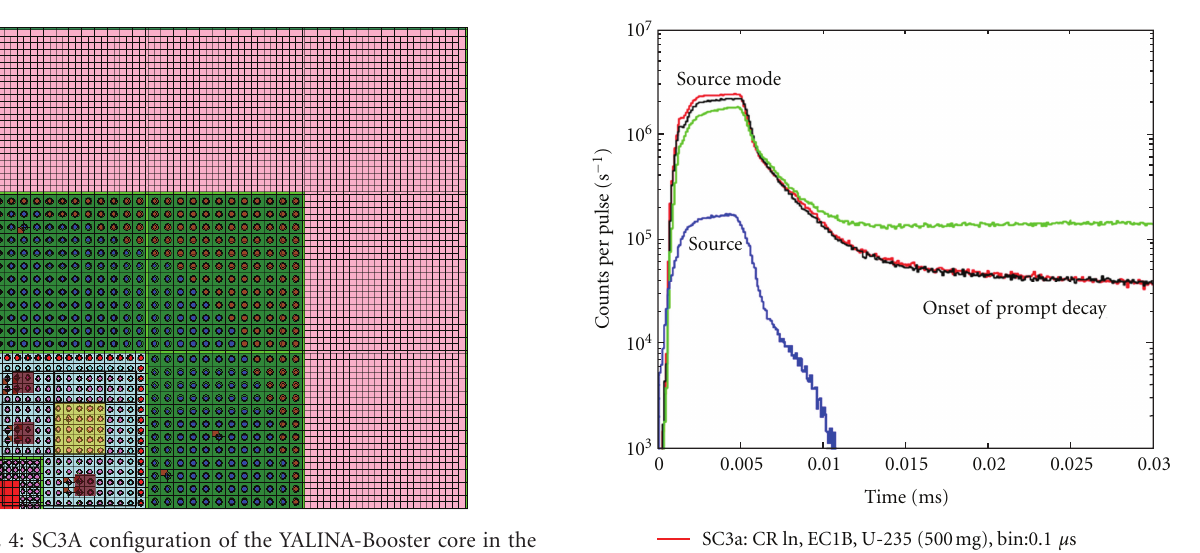
Figure 4: SC3A configuration of the YALINA-Booster core in the HELIOS model for XS preparation.